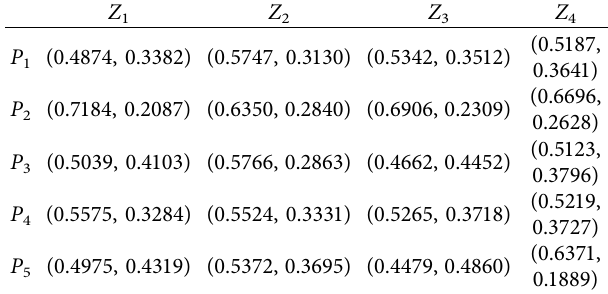
Table 7: The normalized intuitionistic fuzzy matrix.